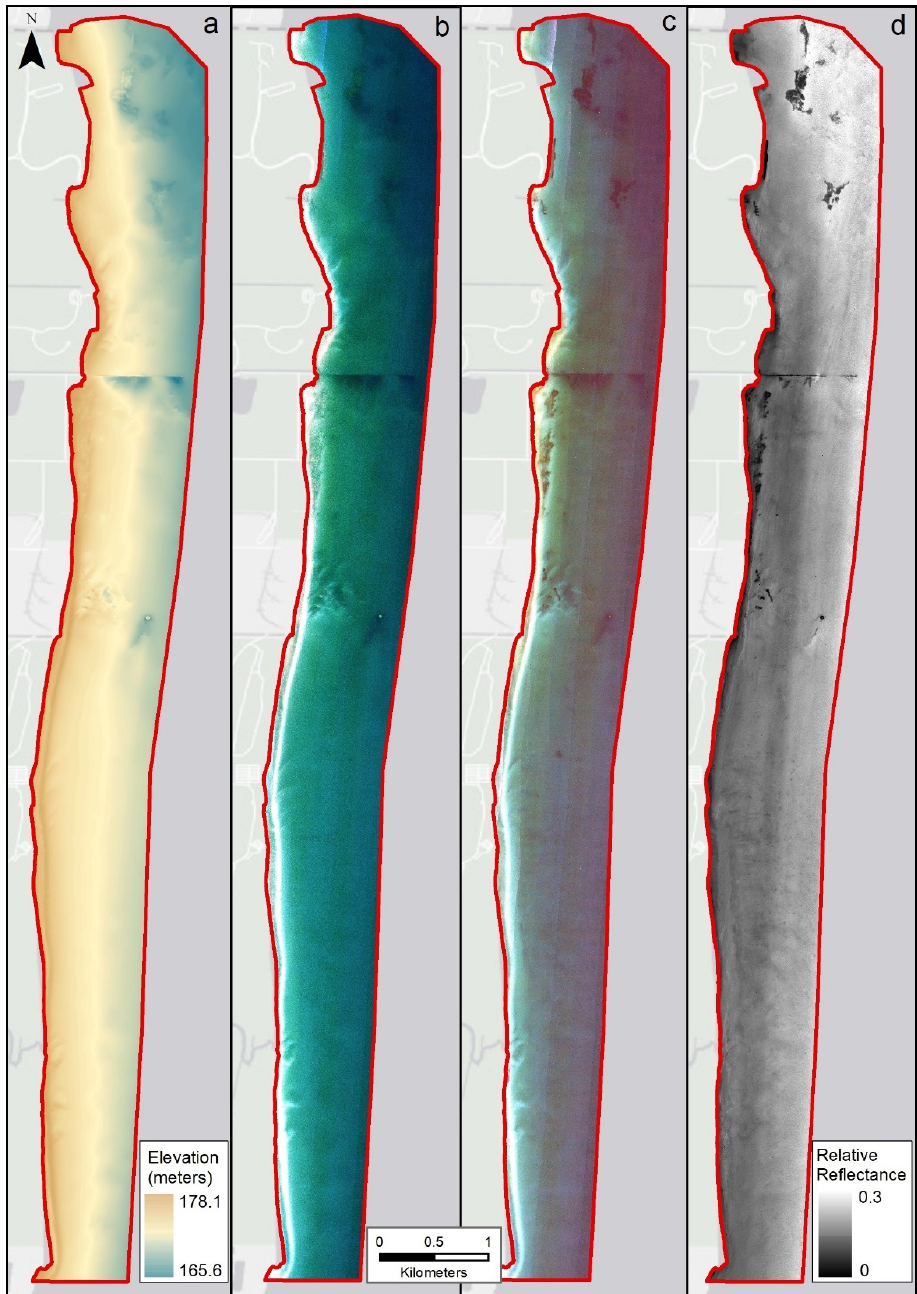
Figure 2. Airborne data products: ( a ) bathymetry, ( b ) hyperspectral water-leaving reflectance, ( c ) fusion, and ( d ) bathymetric reflectance.